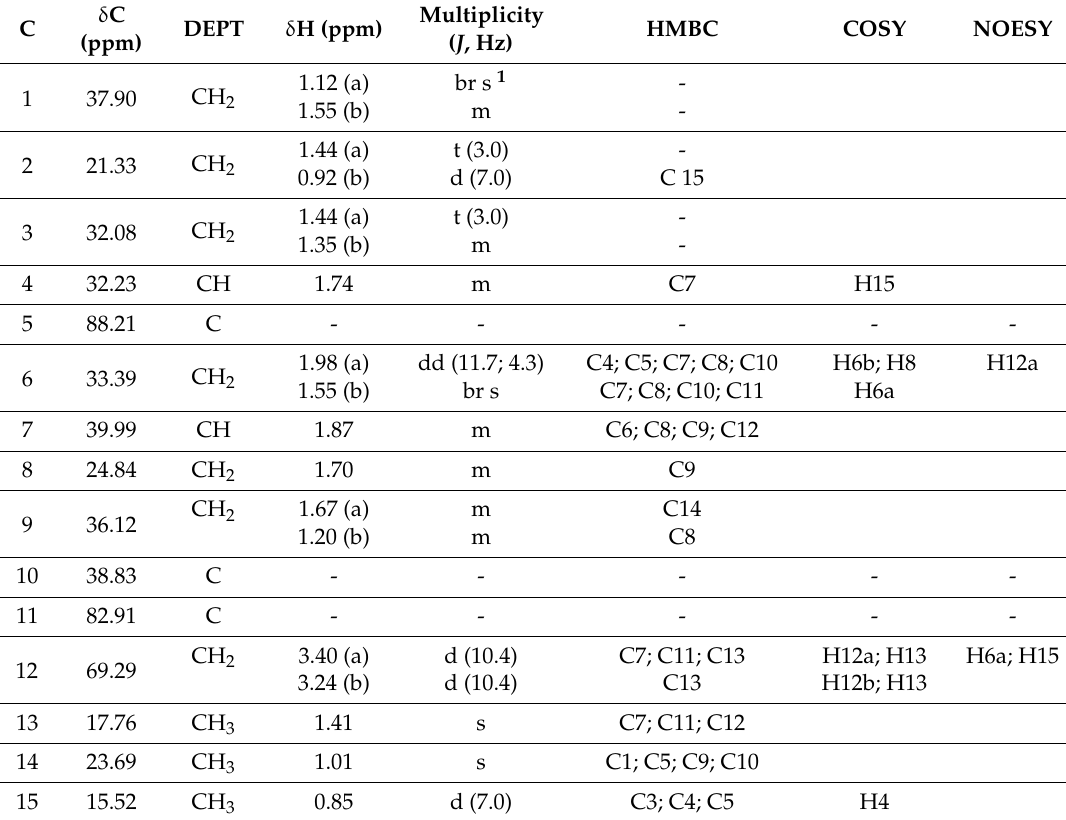
Table 3. NMR data of 12-hydroxyisodihydroagarofurane ( 39